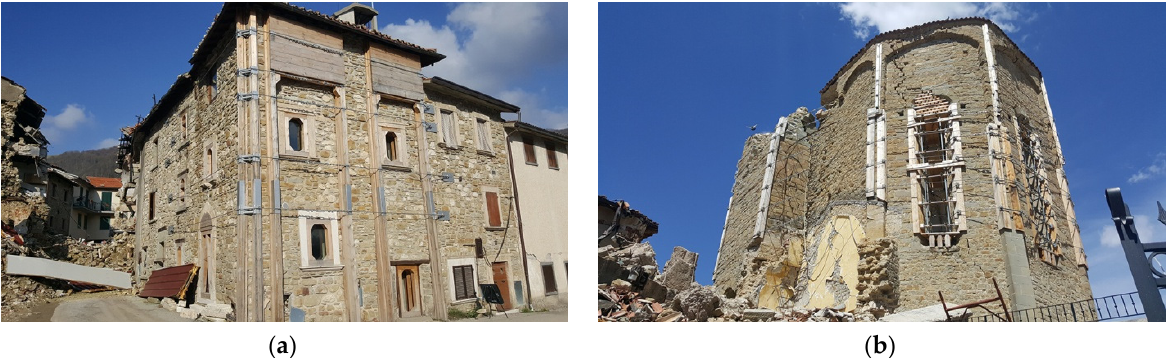
Figure 2. ( a ) Damaged masonry buildings in the area around the epicenter of the 2016 Central Italy earthquake; ( b ) St. Francesco church in Amatrice, damaged by the same earthquake.